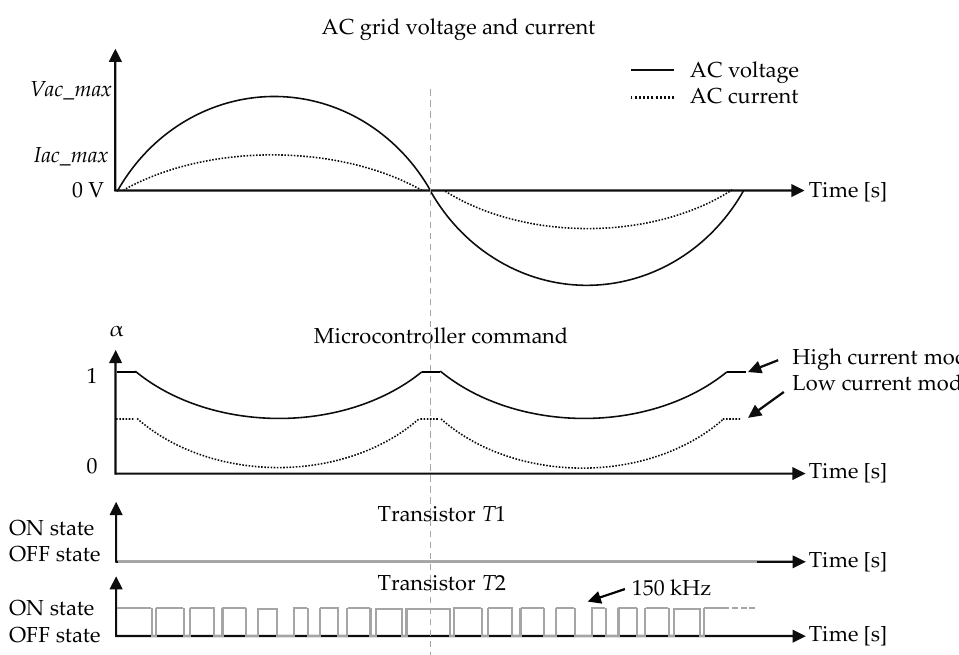
Figure 7. Control strategy of the MOSFETs inside the proposed bidirectional DC–AC converter used in PFC rectifier mode.